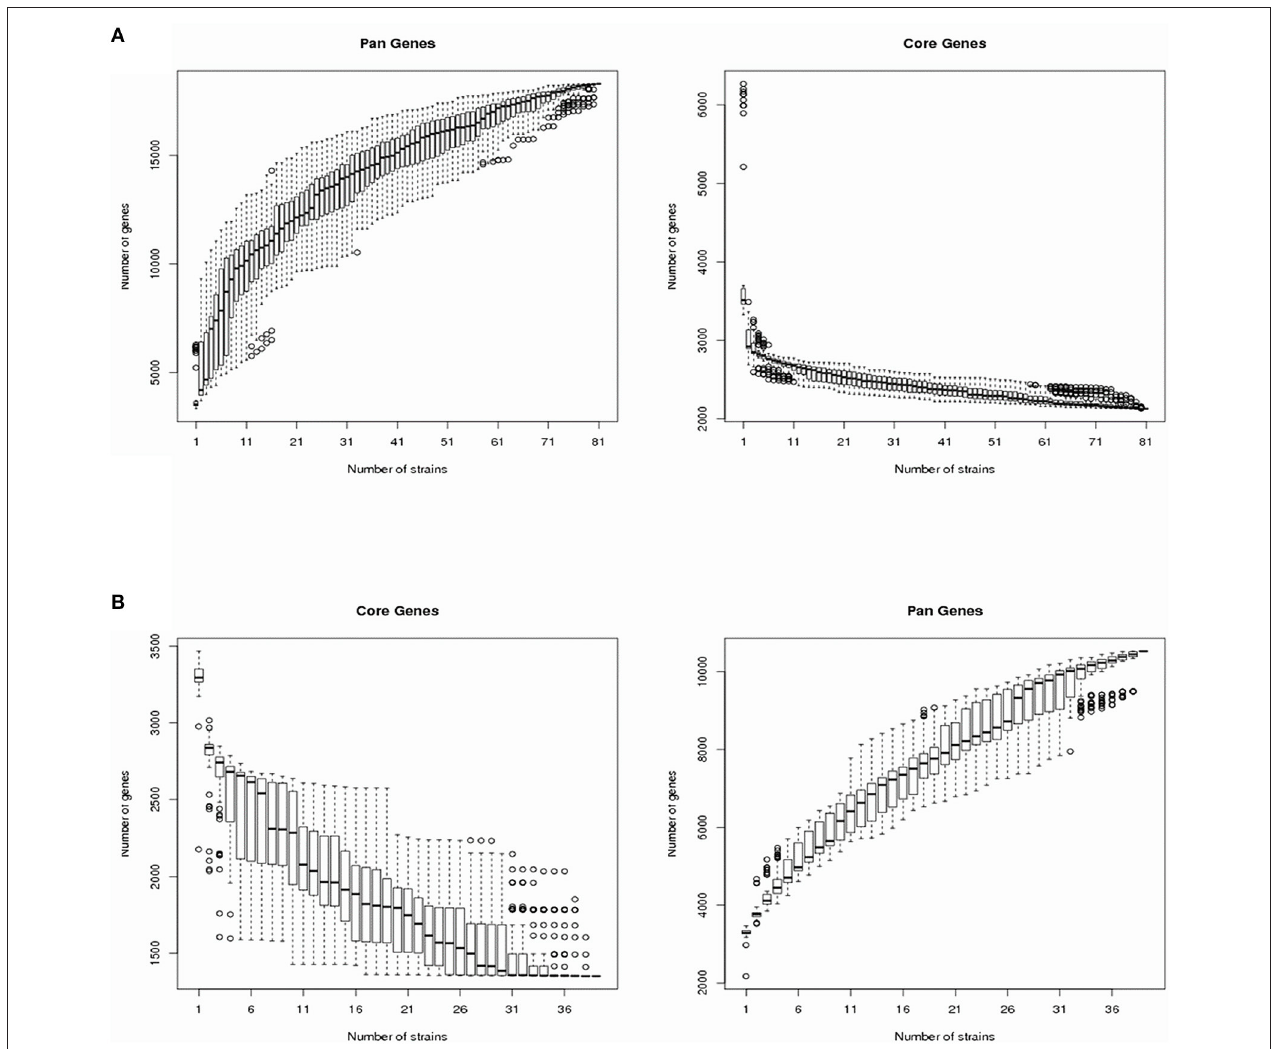
FIGURE 1 | Vibrio cholerae and Vibrio metschnikovii core-/pan-genome diversity curves. (A) The V. cholerae core- and pan-genomes are shown as a function of the number of genomes included in the counts. Boxes represent one standard deviation around the median number of genes within the subsets, while the whiskers indicate two standard deviations from the median. (B) The V. metschnikovii core- and pan-genomes are shown as a function of the number of genomes included in the counts. Boxes represent one standard deviation around the median number of genes within the subsets, while the whiskers indicate two standard deviations from the